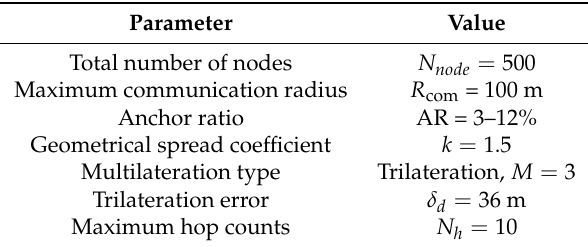
Table 1. Parameter